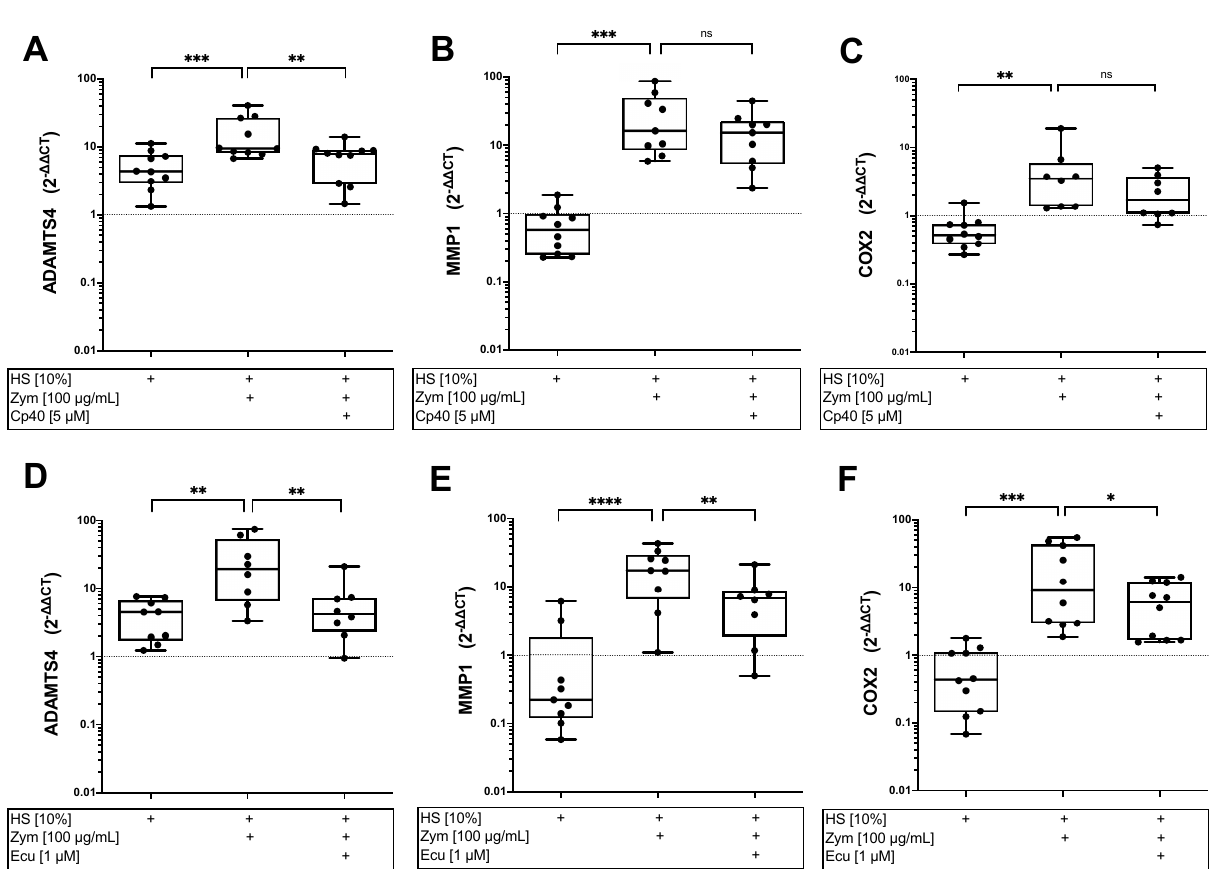
Figure 5. Effect of complement activation and inhibition on gene expression of annulus fibrosus (AF) cells. Gene expression analysis of catabolic enzymes ADAMTS4 ( A , D ) and MMP1 ( B , E ) as well as inflammation marker COX2 ( C , F ) in AF cells stimulated for 24 h with 10% human serum (HS) alone or with zymosan (Zym, 100 µ g/mL) and treated with complement inhibitors Cp40 (5 µ M; ( A – C )) and eculizumab (Ecu, 1 µ M; ( D – F )). Relative gene expressions are presented as box-and-whisker plots with median ± interquartile ranges ( n = 8–10 donors per group). Significant differences are depicted as: * p < 0.05; ** p < 0.01; *** p < 0.001; **** p < 0.0001; ns: not significant. One-way ANOVA was